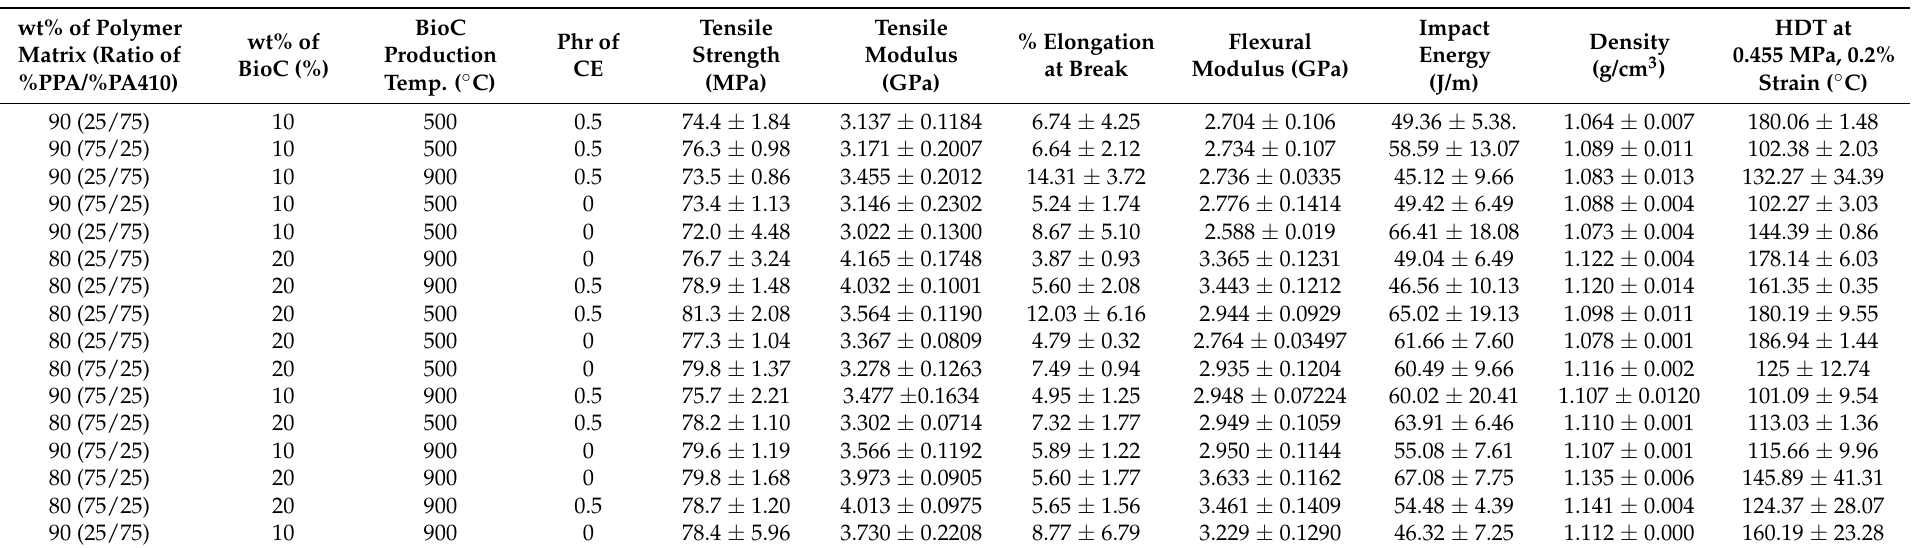
Table 1. Results of tests carried out on all the produced composites.